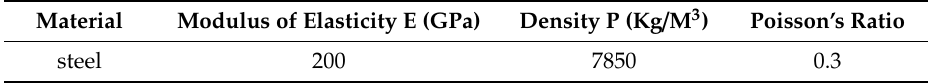
Table 1. Structural material